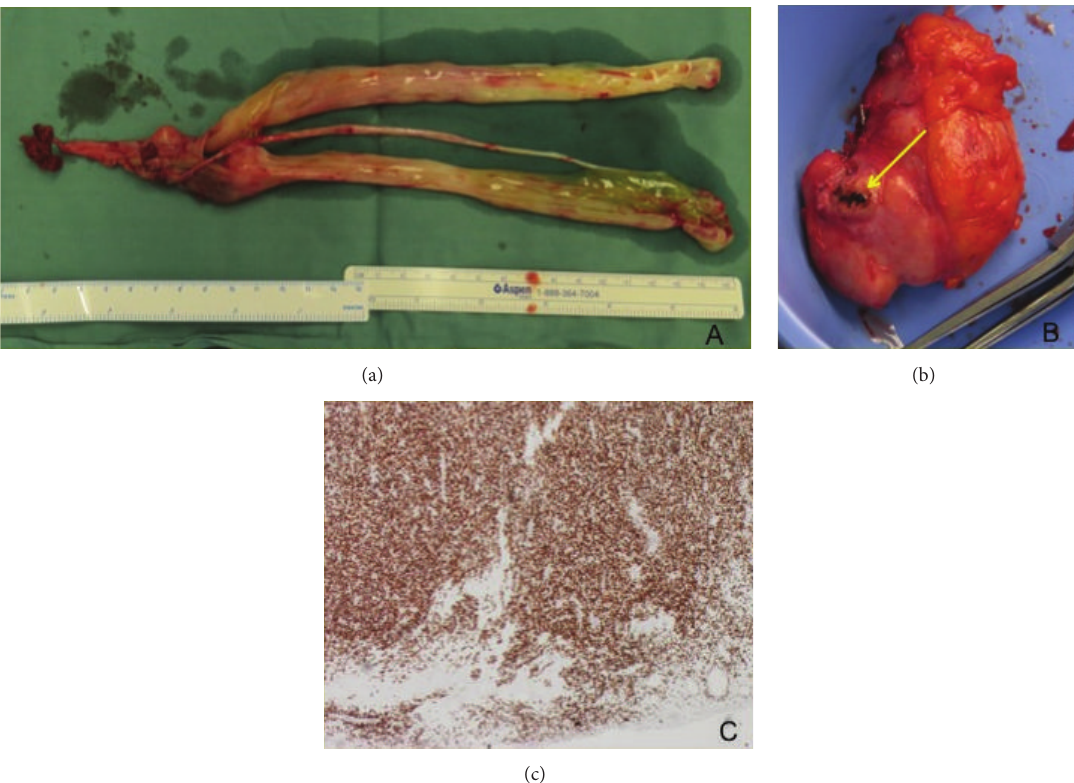
Figure 5: (a) Gross specimen of the tumor resected from the IVC venotomy during second-stage procedure and (b) pelvic mass with venous attachment site (yellow arrow) with (c) strongly positive staining of IVC tumor specimen for estrogen